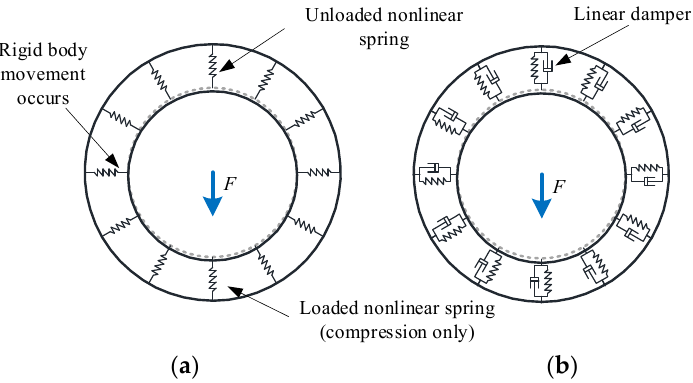
Figure 5. Replace rollers with nonlinear springs and dampers. ( a ) Replace rollers with springs; ( b ) Replace rollers with springs and dampers.